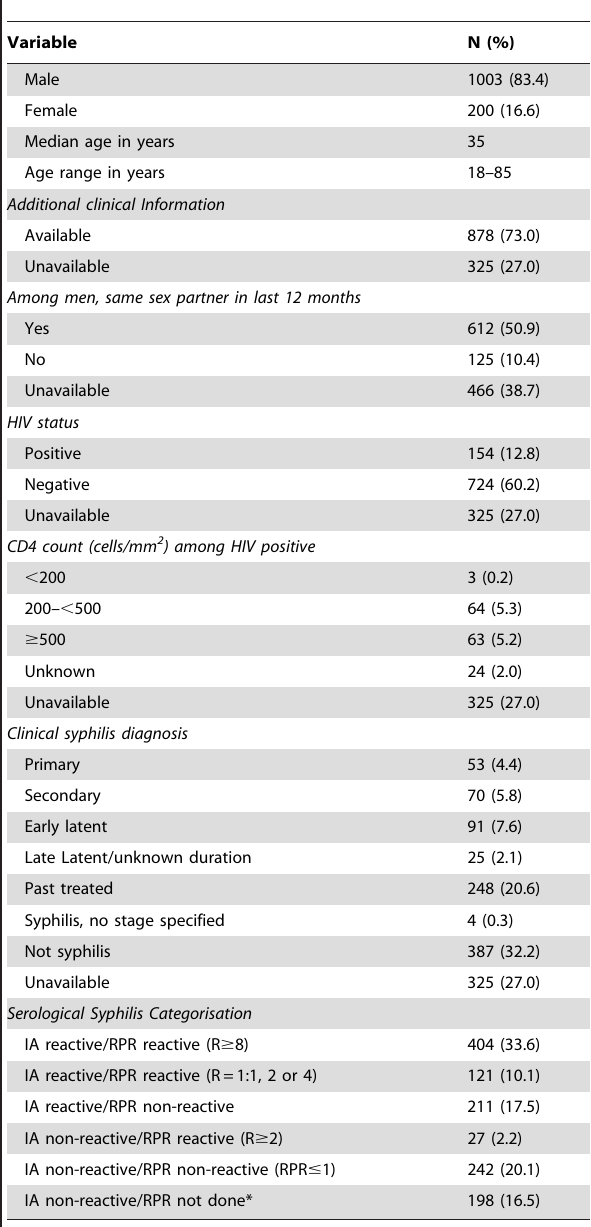
Table 2. Selected demographic and clinical characteristics of specimens tested (n=